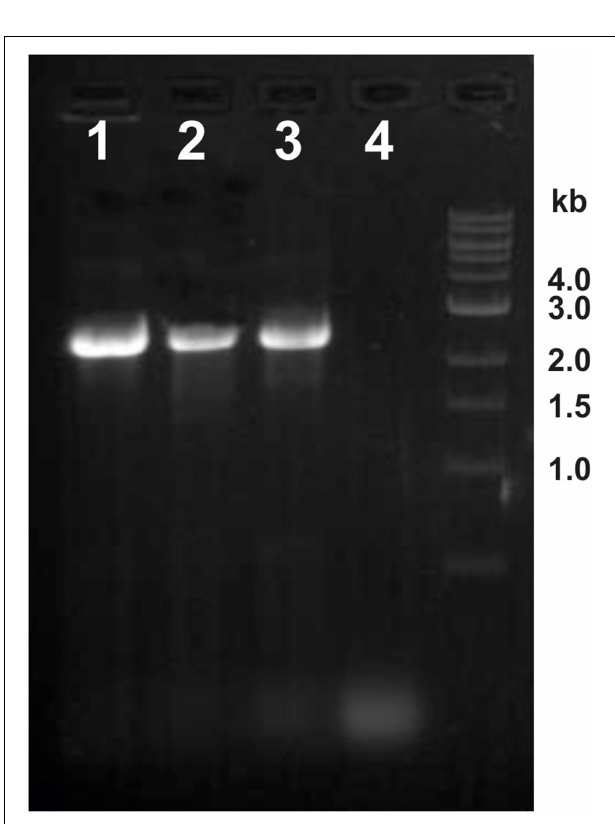
FIGURE 5 | Detection of the flaB0 gene in three different P. furiosus strains. Genomic DNA was isolated from the three strains P. furiosus Vc1 T , BBR, and LS and used for PCR amplification with primers 353483 f and 351761 r . Very clearly a ca. 2.5kb amplificate was identified in all three strains; if flaB0 would be missing (as in the original sequence) a ca.